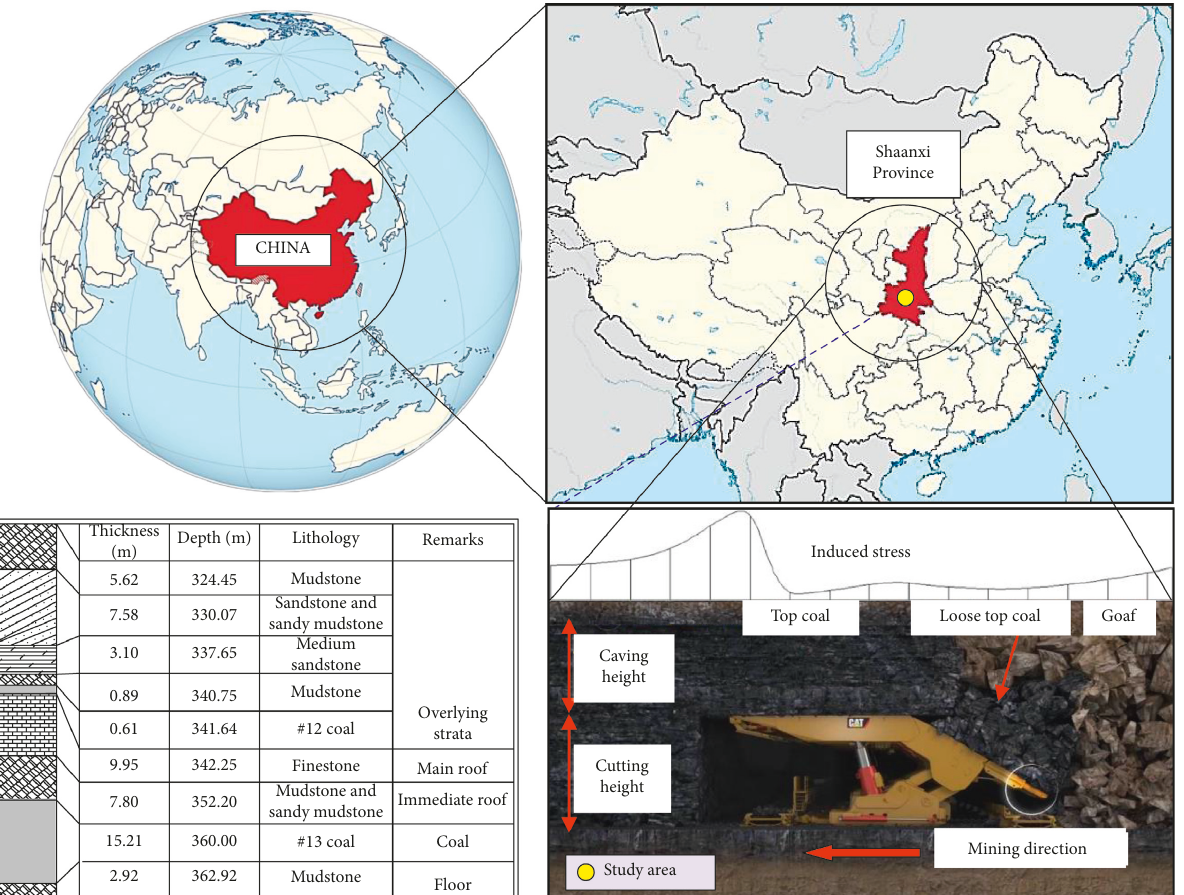
Figure 1: Map showing the location and outline of the studied mine and